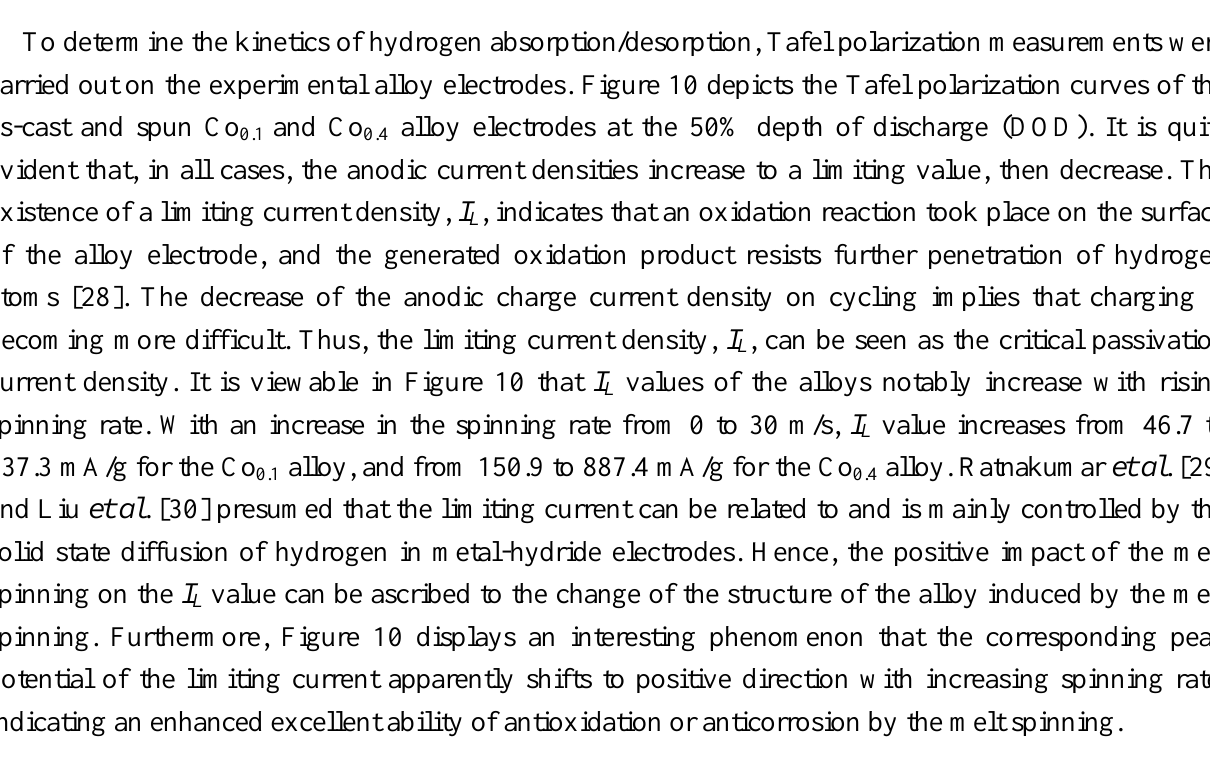
Figure 10. Tafel polarization curves of the as-cast and spun alloy electrodes at the 50% depth of discharge (DOD): ( a ) Co